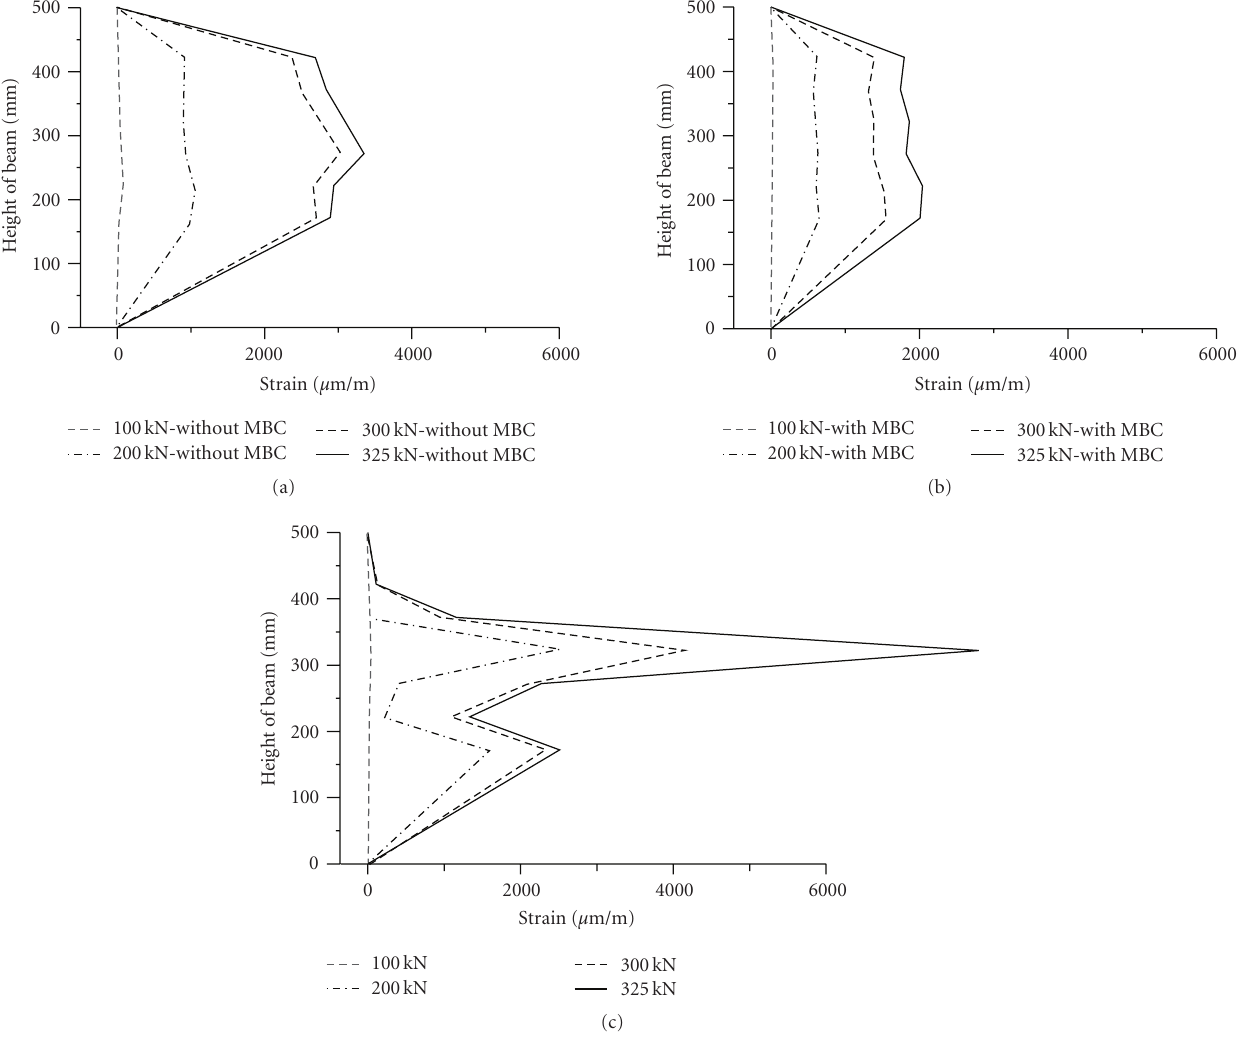
Figure 9: Strain development at di ff erent shear loads. (a) in stirrups without MBC and (b) in stirrups with MBC and (c) strains in vertical CFRP